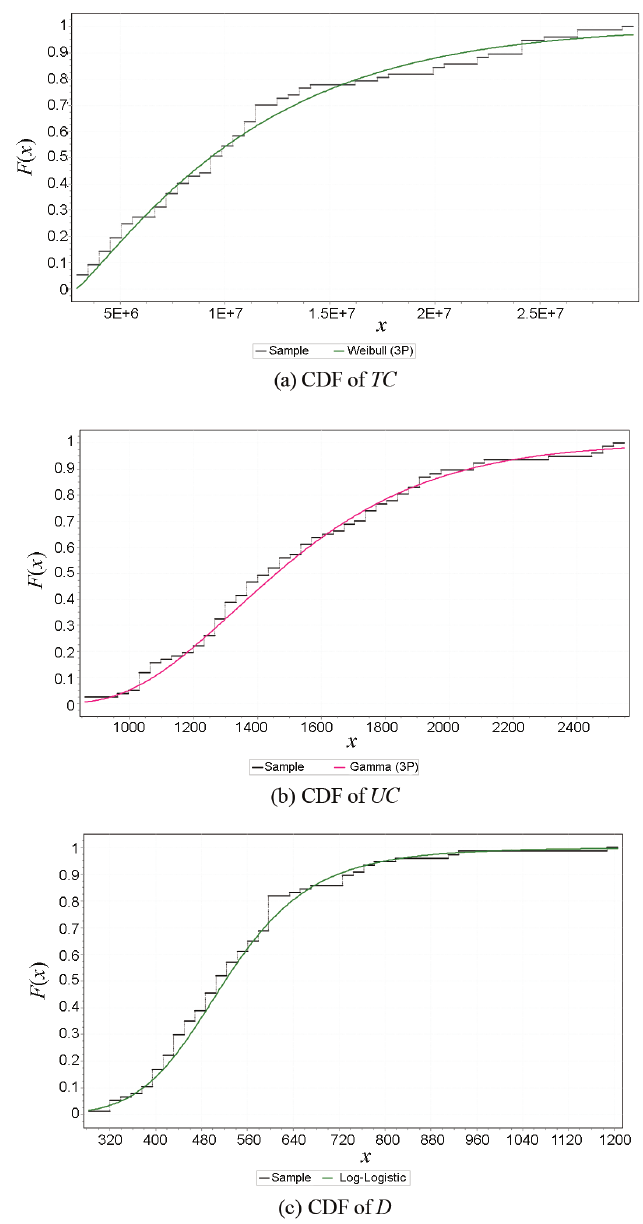
Figure 3. Best fit distributions of TC , UC and